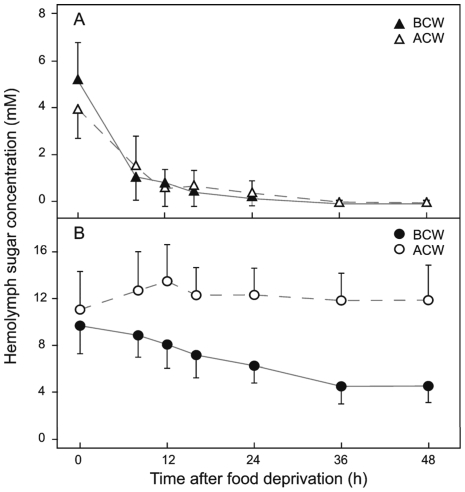
Effect of starvation on hemolymph glucose and trehalose concentration.(A) Glucose concentration in larvae starved before (BCW) and after critical weight (ACW). (B) Trehalose concentration in larvae starved before and after critical weight. Values are means of 8–16 independent samples ±SD.